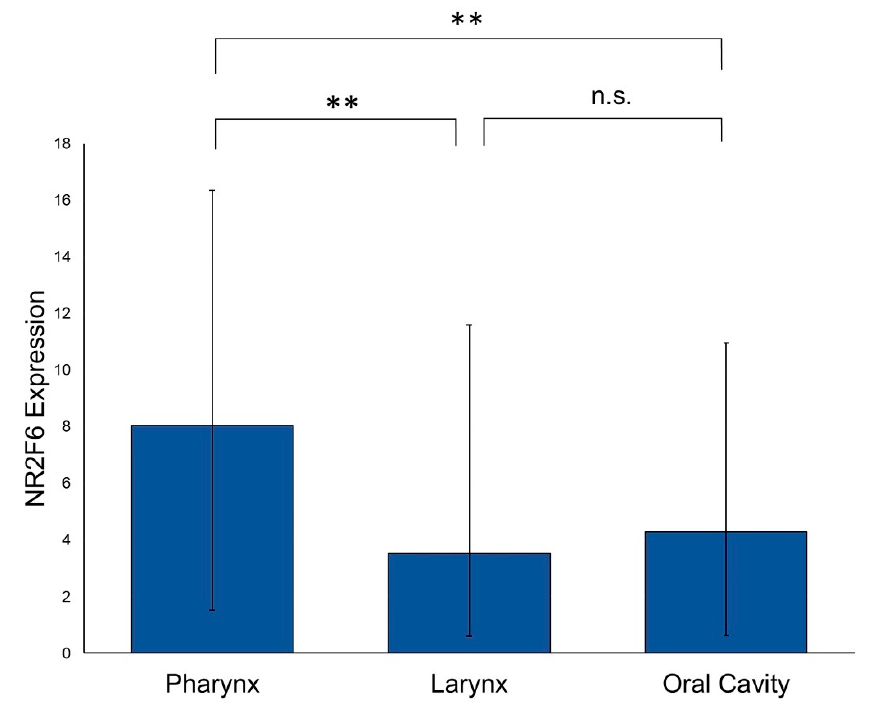
Figure 3. NR2F6 expression in different HNSCC tumor sites. The NR2F6 expression is significantly higher in pharyngeal HNSCCs than in laryngeal (Mann–Whitney test, p = 0.008) and oral cavity HNSCCs (unpaired t -test, p = 0.004). There is no significant difference between laryngeal and oral cavity HNSCCs. (** p ≤ 0.01; n.s. = not significant).